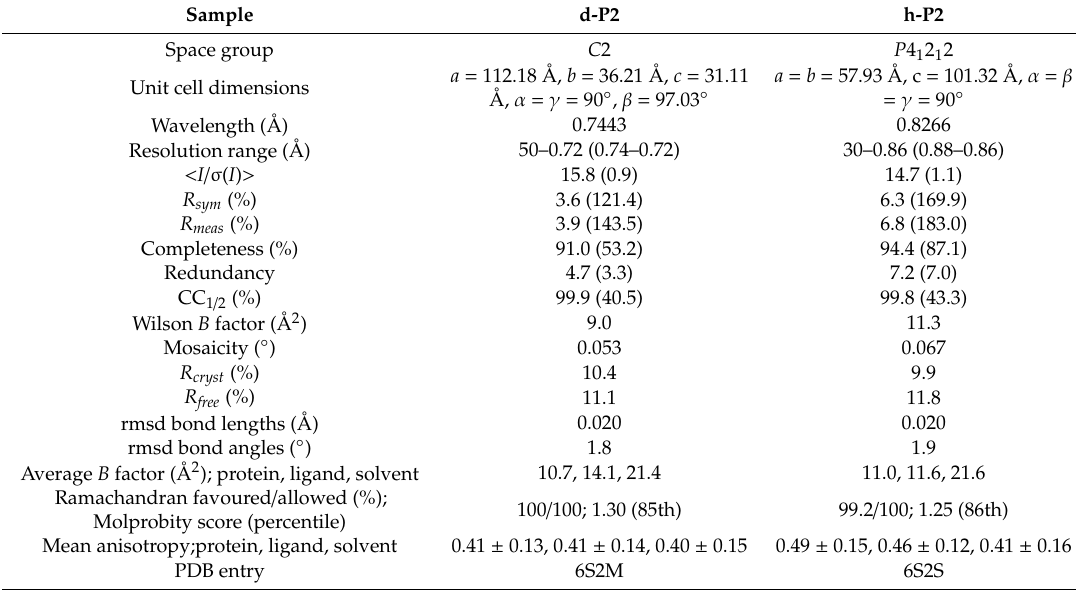
Table 1. Data processing and structure refinement. The values in parentheses refer to the highest-resolution shell.